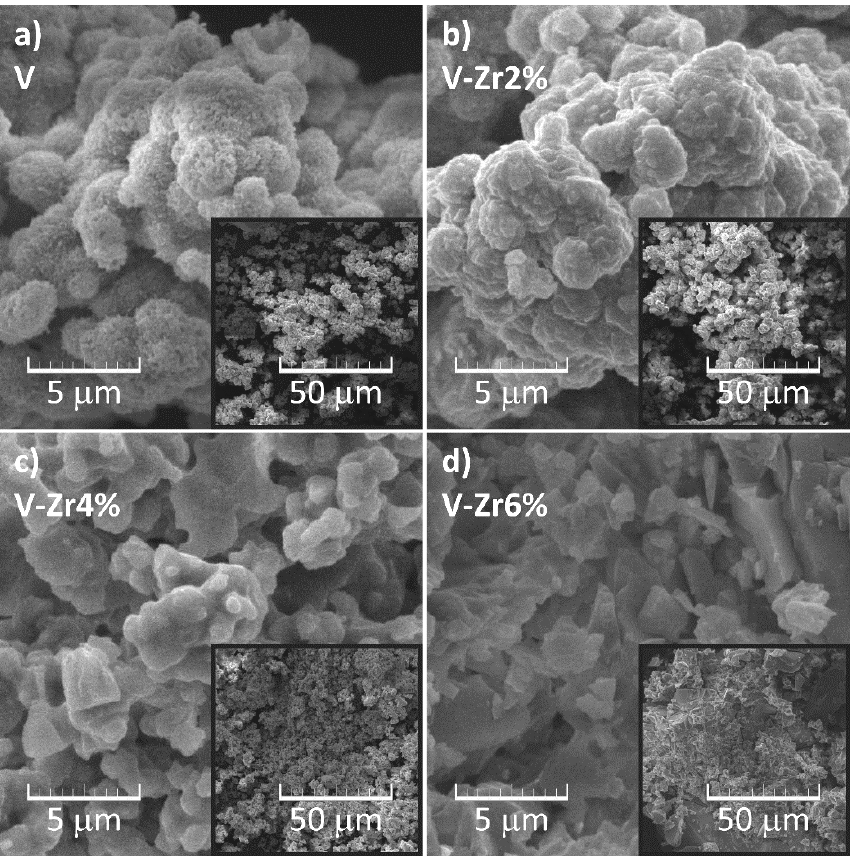
Figure 8. SEM micrographs of ( a ) the pure V, ( b ) V-Zr2%, ( c ) V-Zr4%, and ( d ) V-Zr6% precursor samples.